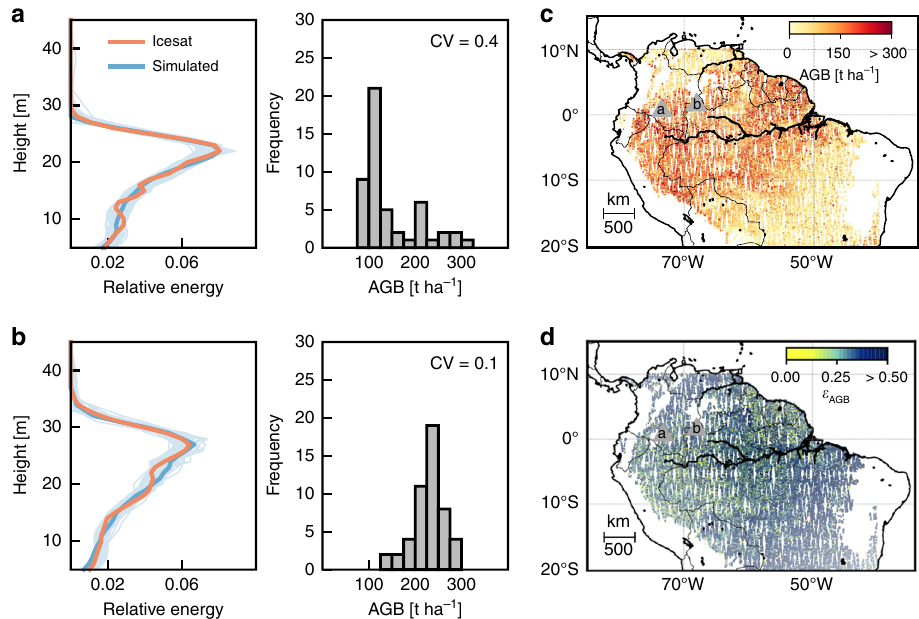
Fig. 2 Two example locations where GLAS lidar pro fi les were matched with forest simulations. a , b left GLAS lidar pro fi le (red) and best matching simulated pro fi les (blue for best relative overlap, light blue for the other 49 simulated pro fi les with highest overlap). The relative overlap of all pro fi les is >90%. a , b right Aboveground biomass (AGB) probability distribution for 50 simulated pro fi les and its coef fi cient of variation (CV). The CV is further denoted as ε AGB , an uncertainty index that describes the structure- and species-induced uncertainty of AGB. c Mean AGB (gray triangles indicate the locations of the two example pro fi les.) and d ε AGB -derived for every GLAS shot. Source data are provided as a Source Data fi le